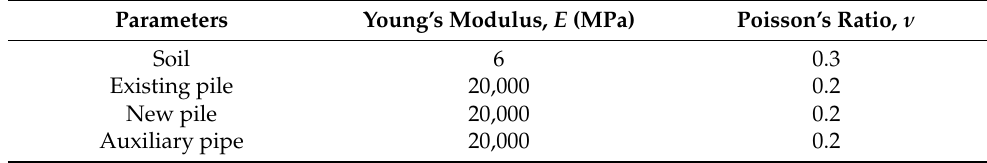
Table 1. Parameters of soil and